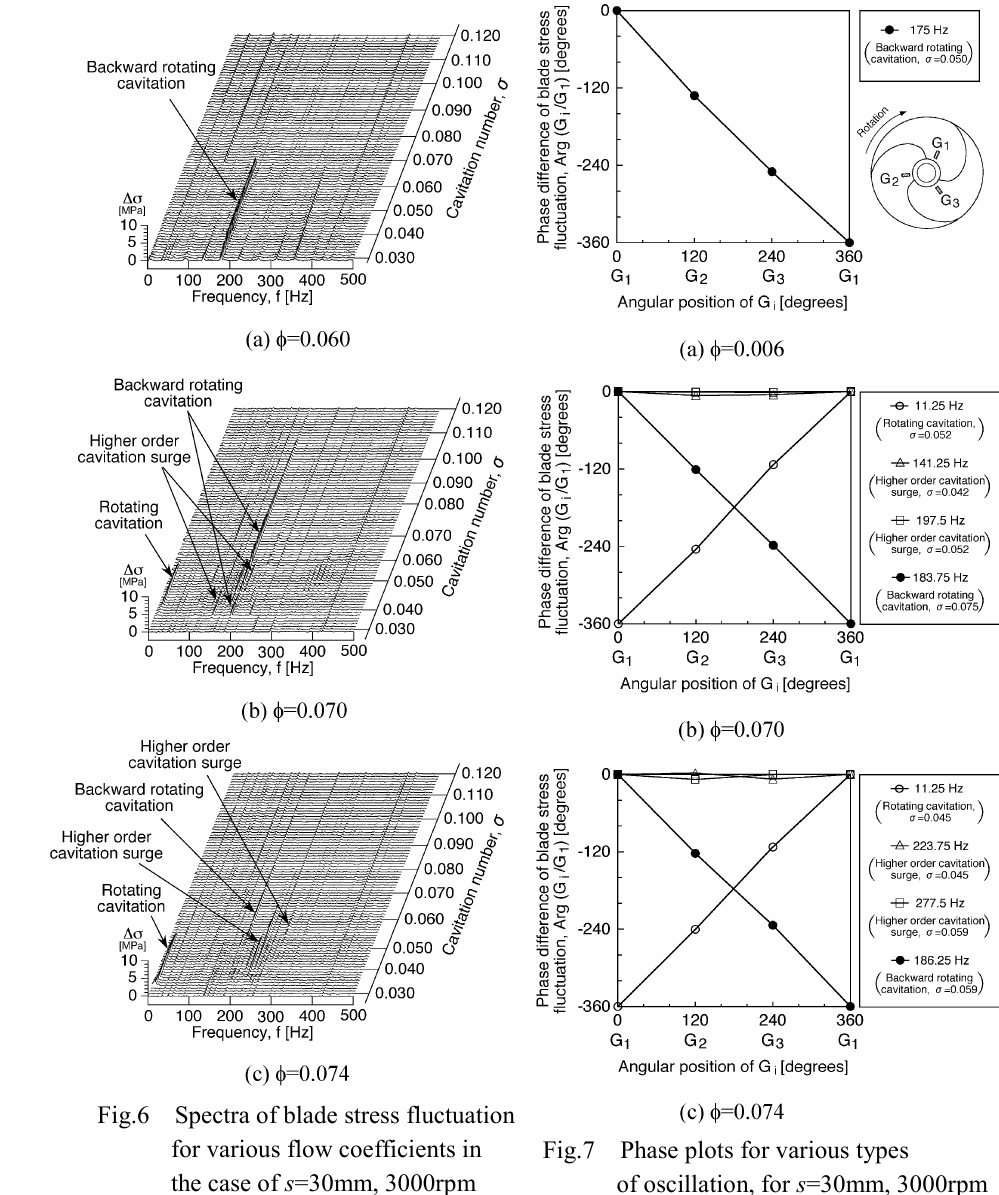
Fig.7 Phase plots for various types of oscillation, for s =30mm,